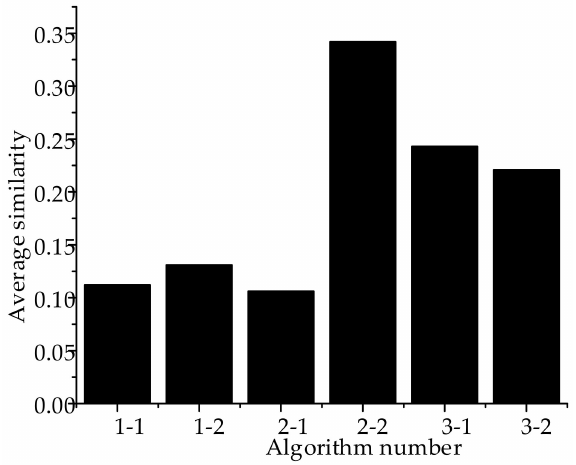
Figure 15. Comparison between AFWA-H-Mine and traditional algorithms of the third